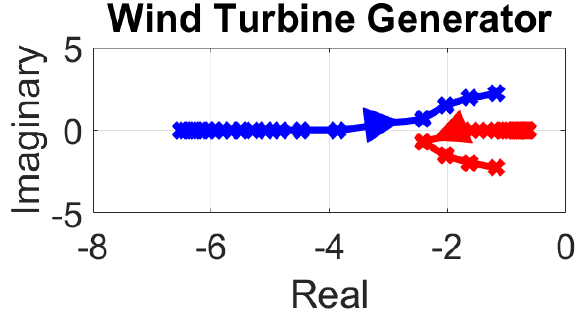
Figure 6. Impact of H on closed-loop poles for Wind Turbine